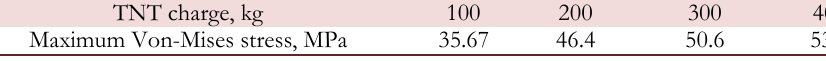
Table 6 : The maximum Von-Mises stress with different charges.